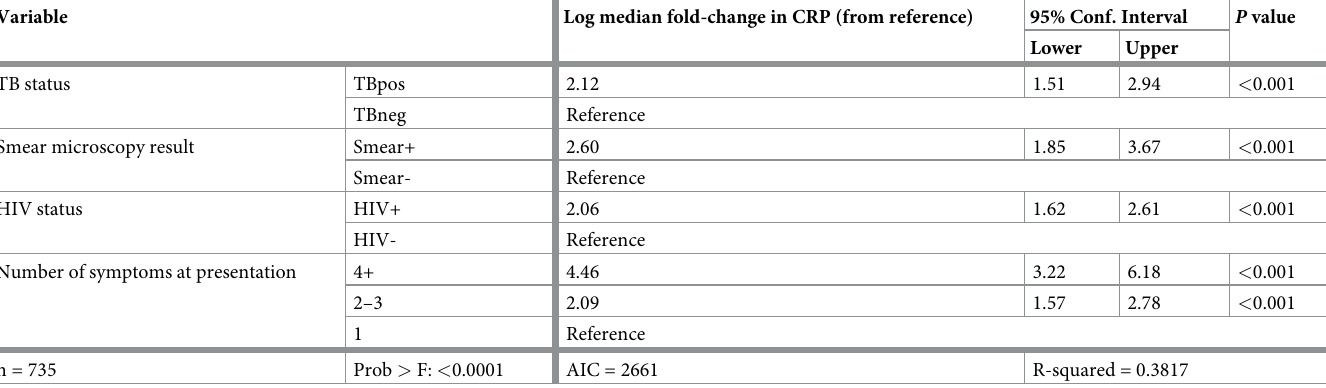
Table 2. Log-scale linear regression model of the effect of shown variables on CRP concentration. Variable Log median fold-change in CRP (from reference) 95% Conf. Interval P value